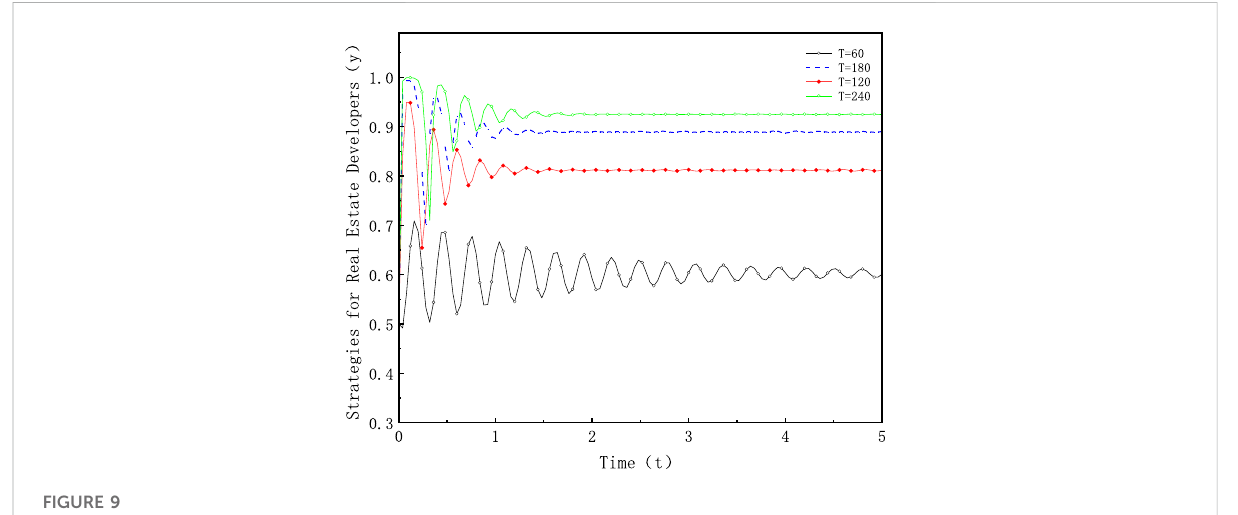
FIGURE 9 Strategies evolution of property developers under different T .